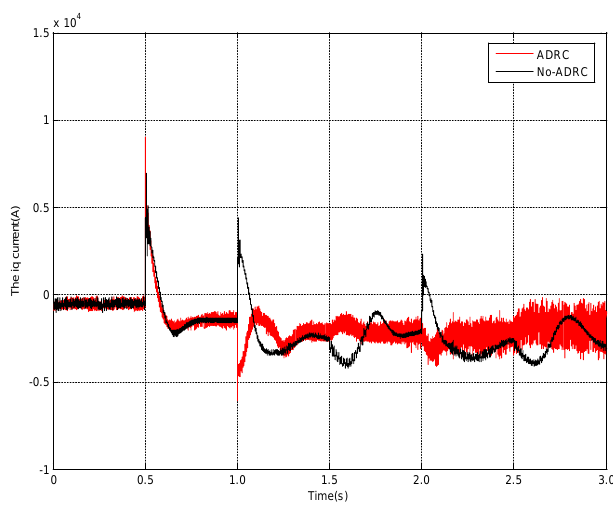
Figure 21. Simulation curve of the q -axis current.